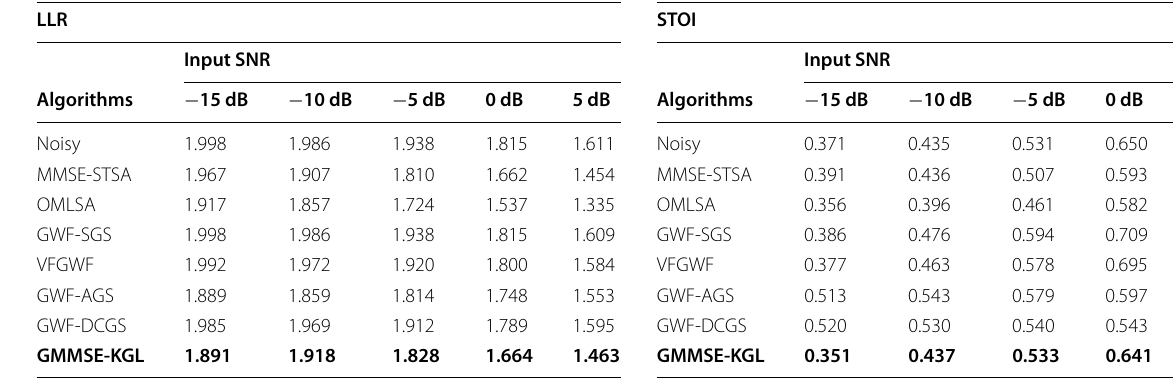
Table 10 The STOI of different methods for Gaussian color